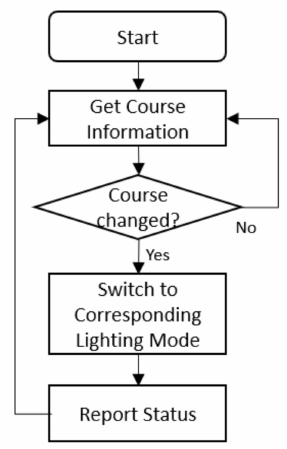
Figure 15. Flowchart of lighting mode switching with class